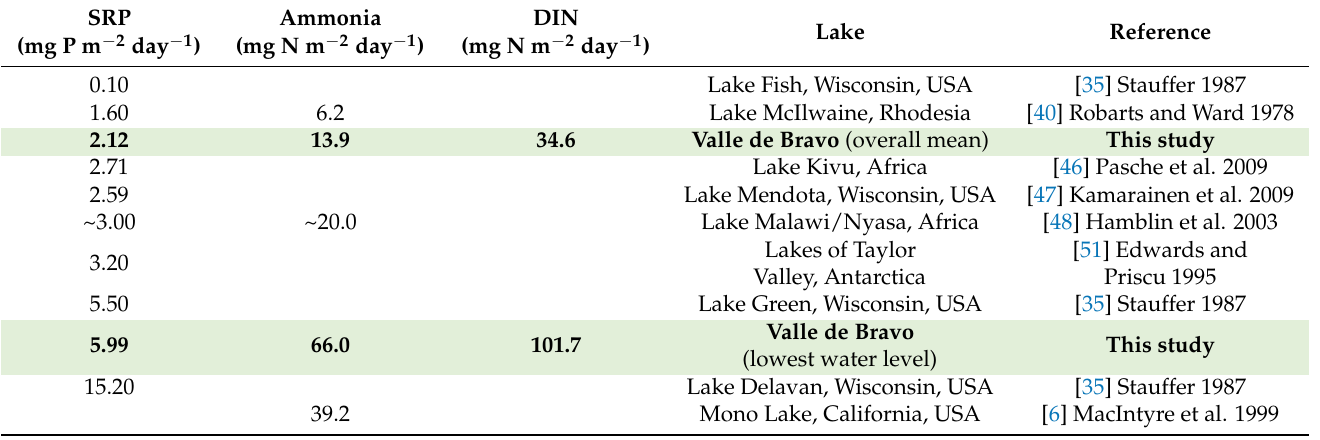
Table 3. Mean Nutrient fluxes obtained for VB during the stratification periods of 2001–2021 and during the stratifications with the lowest water level. Fluxes reported from other lakes are also included for comparison. Other lakes’ data are ordered by increasing SRP flux, and the position of VB fluxes among these values is outlined in bold characters and green shading.